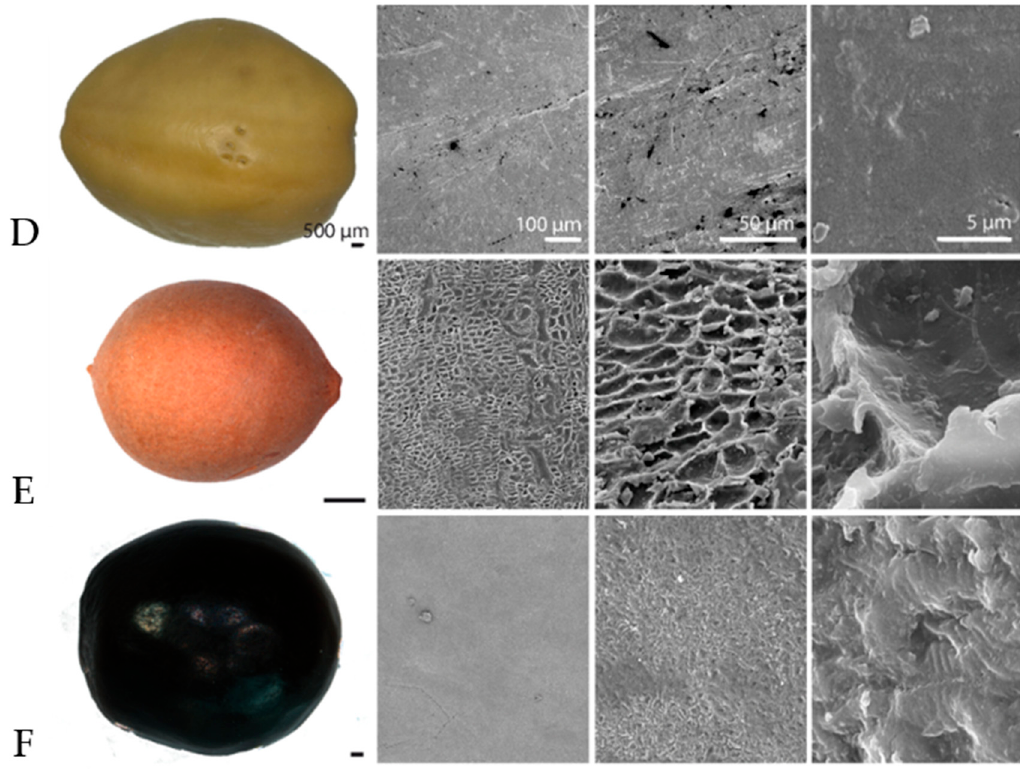
Figure 1. Samples and Scanning Electron Microscopy (SEM) images of seeds with antifouling properties ( A ) Acoelorrhaphe wrightii , ( B ) Coccothrinax borhidiana , ( C ) Erythrina berteroana , ( D ) Ipomoea alba , ( E ) Licuala spinosa and ( F ) Sapindus saponaria .